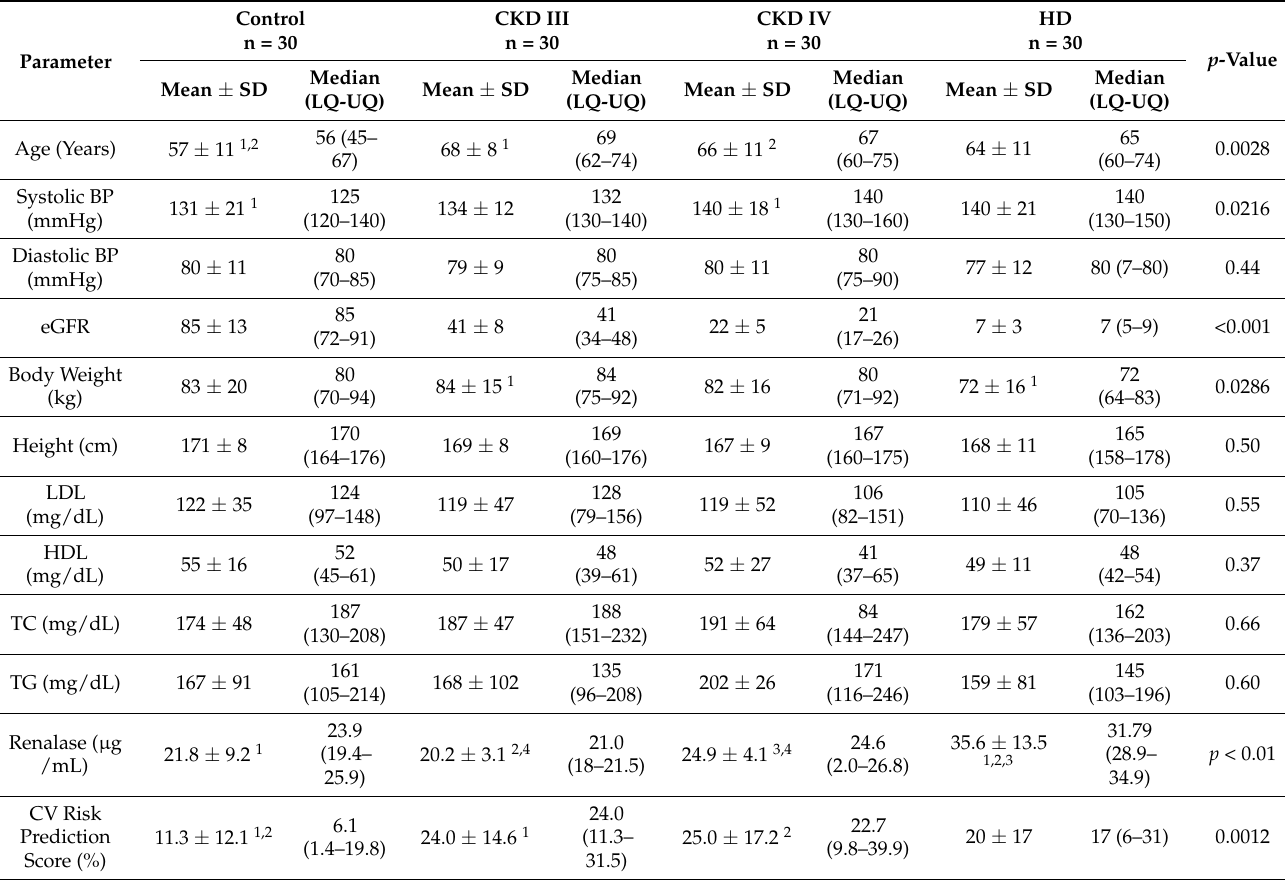
Table 1. Descriptive data of the subgroups together with statistical evaluation (Kruskal-Wallis ANOVA). Data are shown as mean ± SD and median (lower quartile–upper quartile).